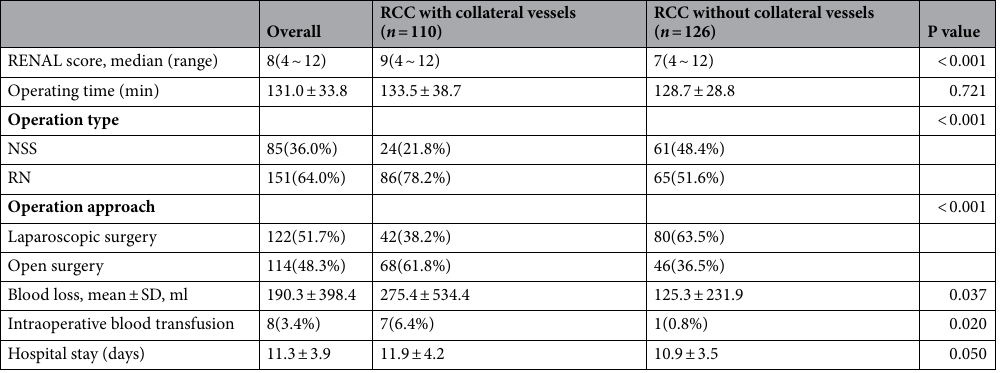
RCC with collateral vessels RCC without collateral vessels Overall ( n = 110) ( n = 126) P value RENAL score, median (range) <